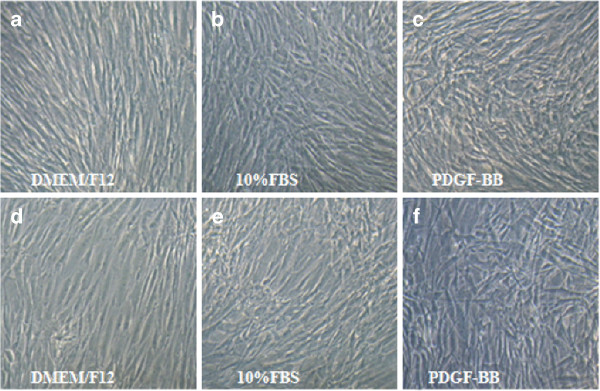
Morphology diversity under distint treated factors (Magnification 10 × 10). SV VSMC: a) DMEM/F12 b) 10%FBS c) 10 ng/ml PDGF-BB. ITA VSMC: d) DMEM/F12 e) 10%FBS f) 10 ng/ml PDGF-BB. a) and d): Cells grew with long and thin shape, refractive index of the cell edge increased. Cells line more compactly, and gradually formed a multil-overlapping, bundles, polarity, similar to the organic assembled VSMCs of the blood vessel wall. b) and e): Cells grew with typical "hill and valley" pattern, from multil-overlapping and non-cell regions. c) and f): Polarity of the cells disappeared, and proliferation were enhanced,form many ultra-overlapping regions.